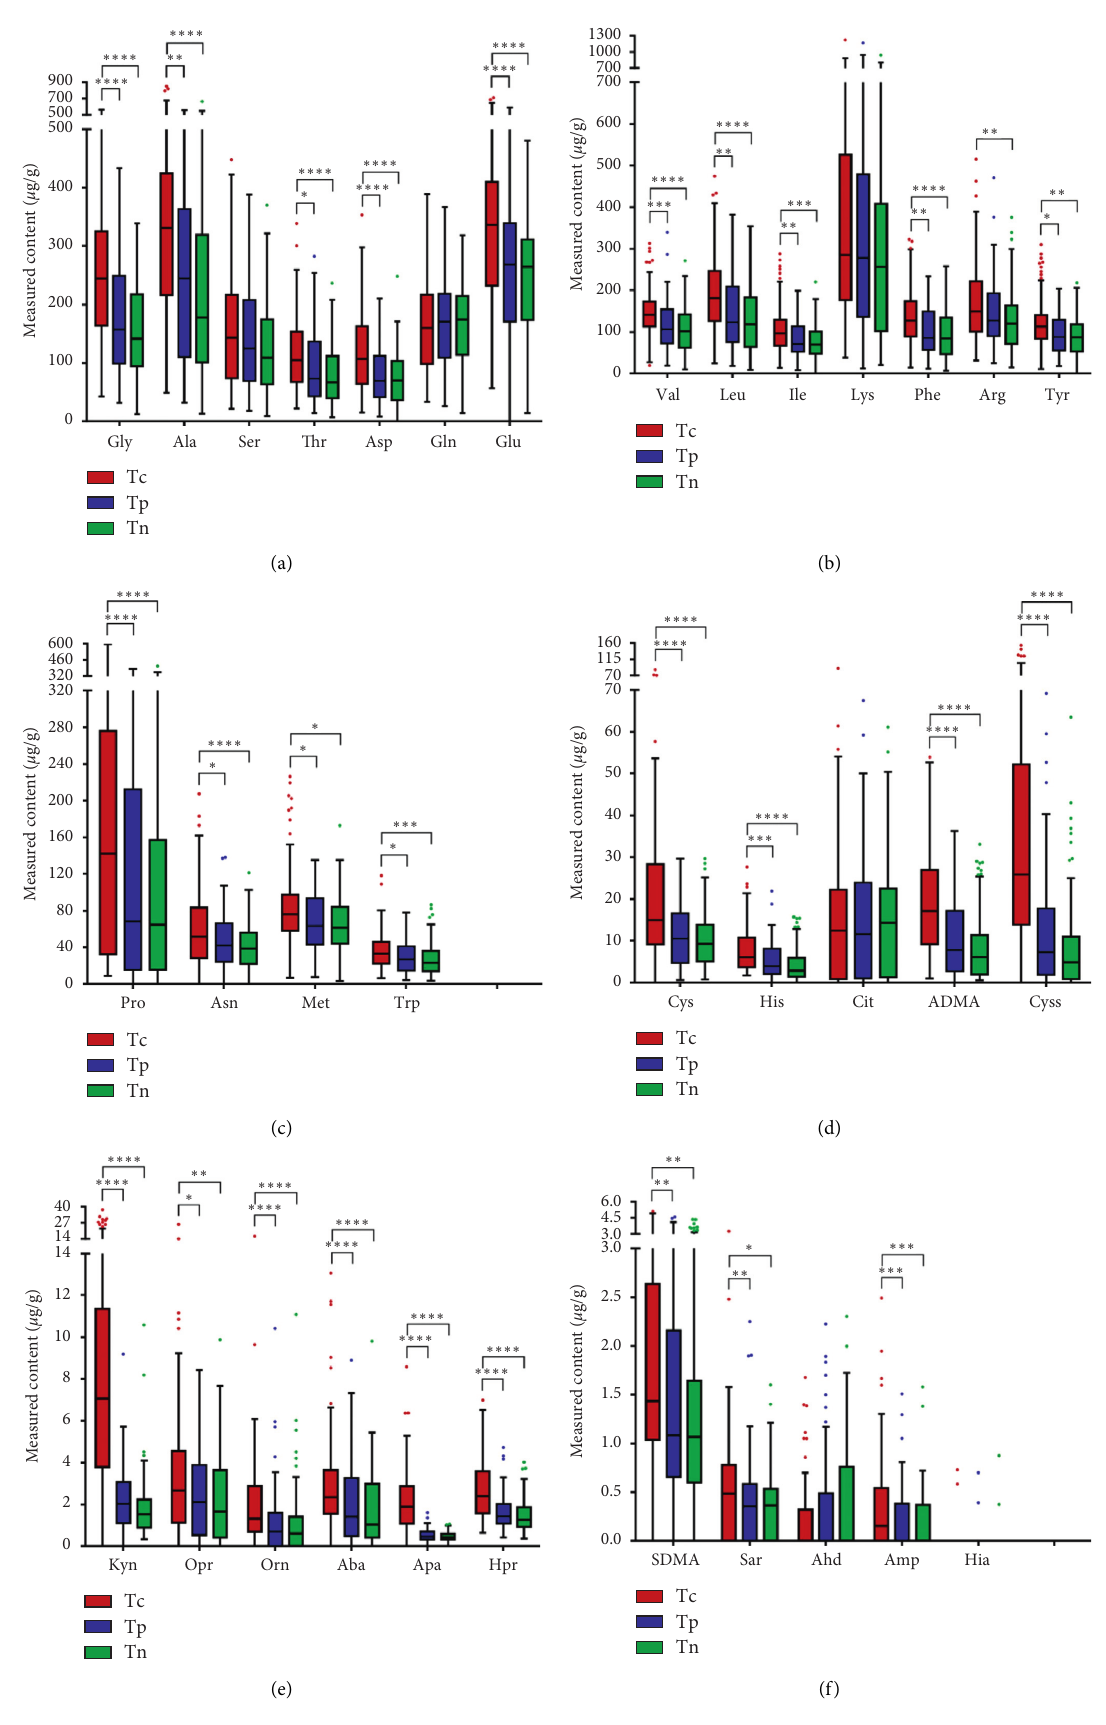
Figure 3: The contents of 34 amino acids in cancerous, paracancerous, and normal tissue from 94 CRC patients ( ∗ p < 0 . 05, ∗∗ p < 0 . 01, ∗∗∗ p < 0 . 001, and ∗∗∗∗ p < 0 .